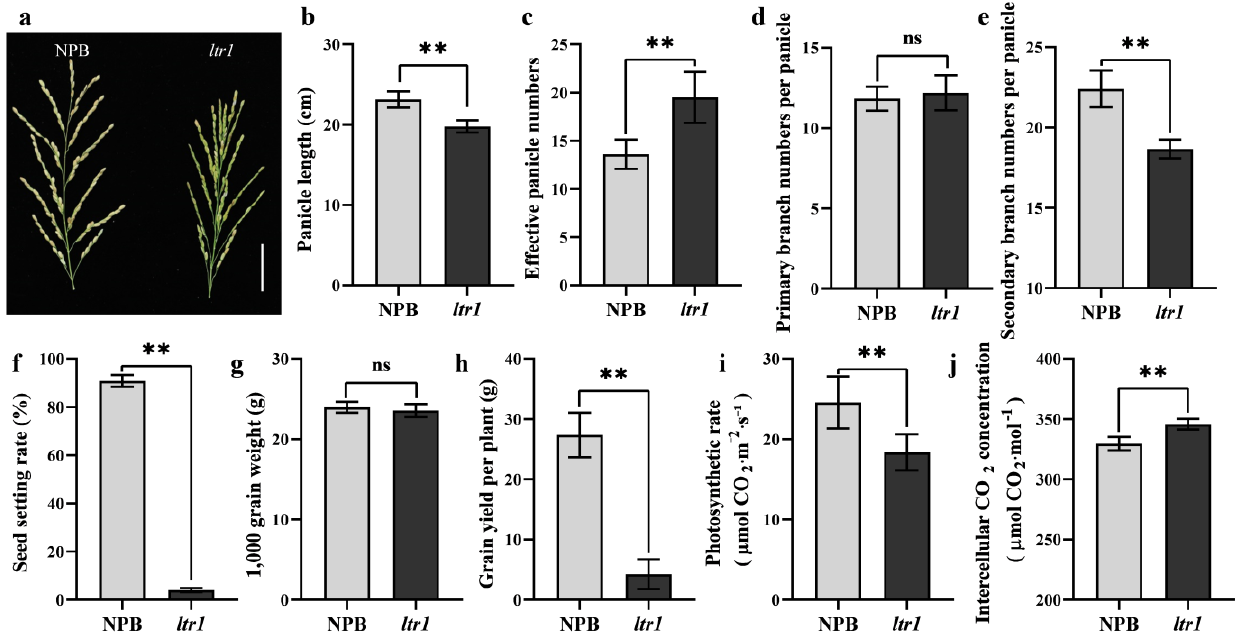
Figure 2. Comparisons of yield characters in NPB and ltr1 . ( a ) Spike morphology, bar = 4 cm, ( b ) panicle length, ( c ) numbers of effective panicle, ( d ) number of primary branches, ( e ) number of secondary branches, ( f ) seed setting rate, ( g ) 1000-grain weight, ( h ) grain yield per plant, ( i ) photosynthetic efficiency, and ( j ) intercellular CO 2 concentration of NPB and ltr1 . Data are given as means ± SD. Asterisks indicate significant difference based on the Student’s t -test: ** in the figure represents significant difference at p < 0.01 and ns in the figure represents there is no significant different at p <